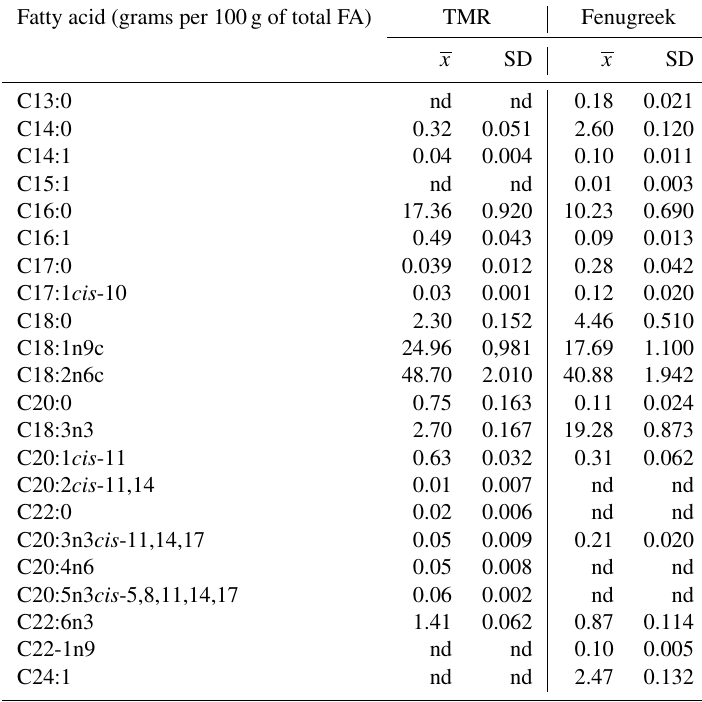
Table 2. Fatty acid (FA) profile of TMR and fenugreek seed consumed by goats. Fatty acid (grams per 100g of total FA) TMR